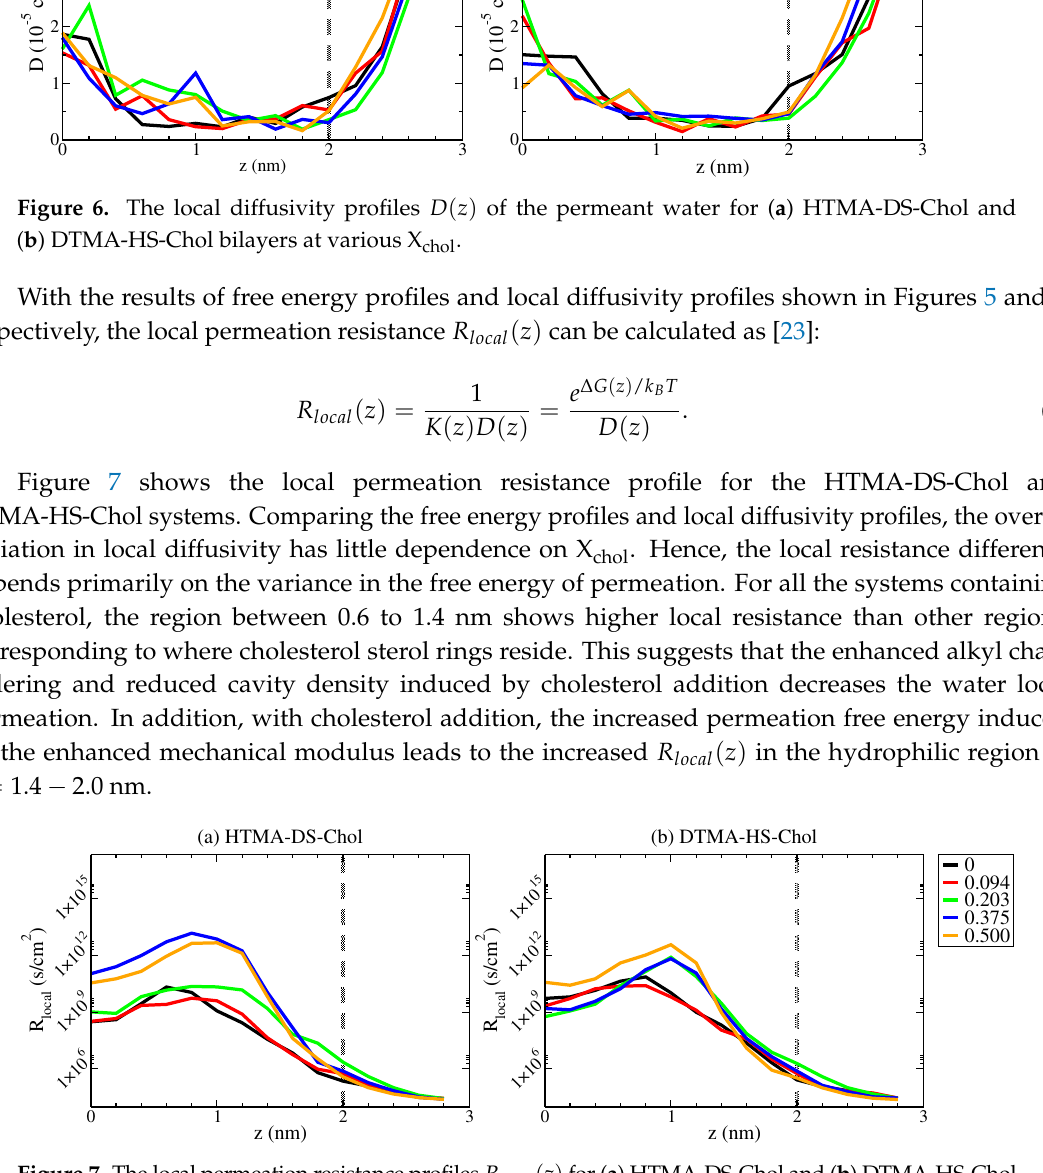
Figure 7. The local permeation resistance profiles R local ( z ) for ( a ) HTMA-DS-Chol and ( b ) DTMA-HS-Chol bilayers at various X chol